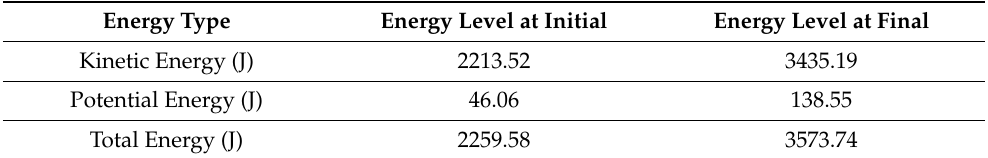
Table 4. Energy data.